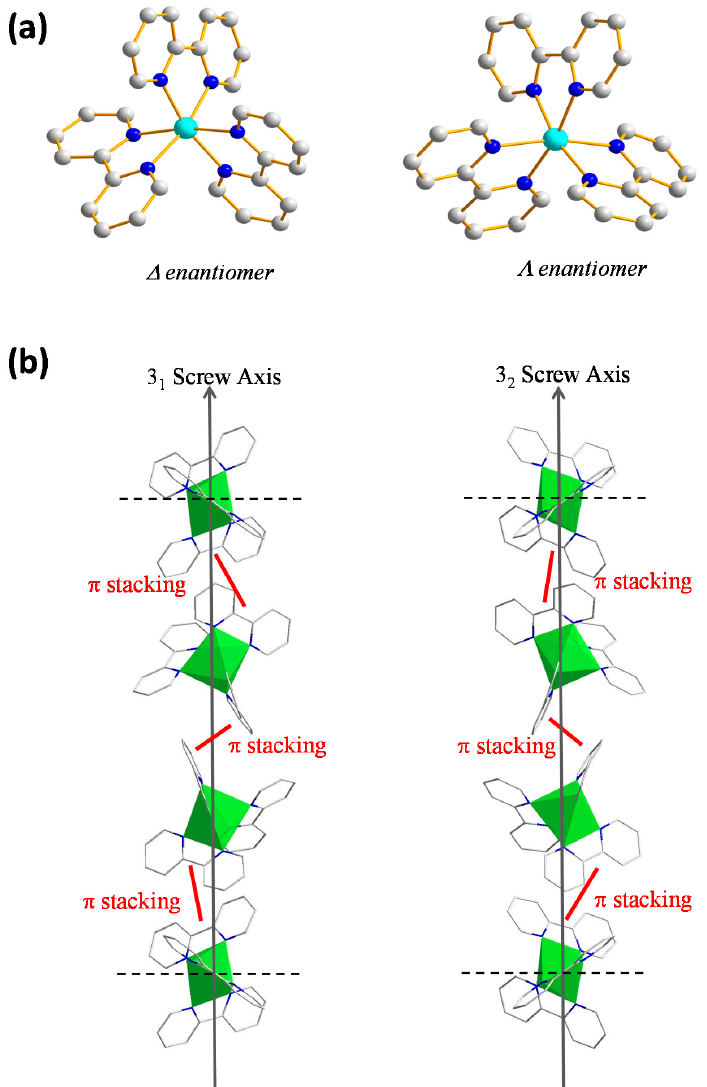
Figure 3. View of ( a ) the two enantiomers Δ and Λ -[Zn(2,2’-bipy) 3 ] 2+ , along the three-fold rotation axes, and ( b ) the two enantiomorphic 3 1 and 3 2 helices built from Δ and Λ -[Zn(2,2’-bipy) 3 ] 2+ , respectively; -stacking occurs between [Zn(2,2’-bipy) 3 ] 2+ helicates.